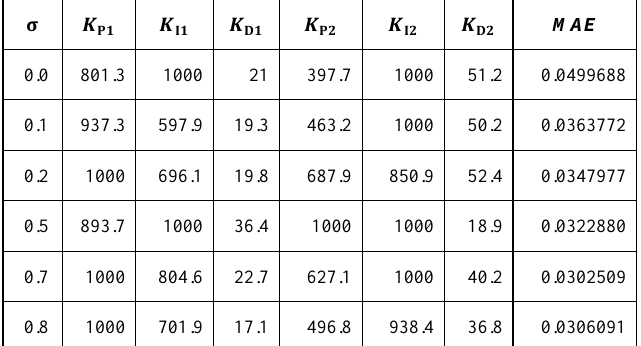
Fig. 17. RBECE optimal applied torque.